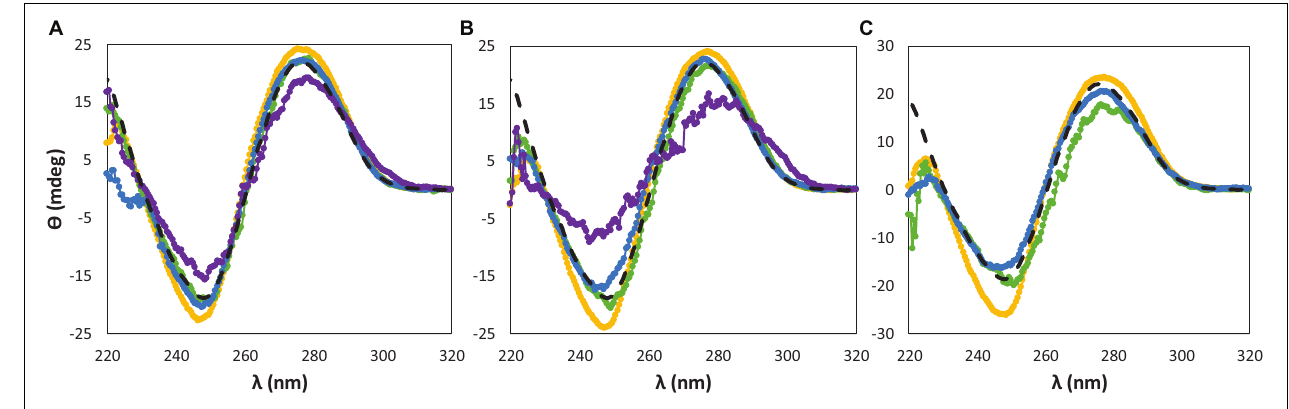
FIGURE 2 | CD spectra regarding the ellipticity, θ , of 0.01 g dm − 3 of β -DNA (from salmon testes) as a function of wavelength, λ , in 10 mM of Tris–HCl buffer (pH ≈ 7.2) aqueous solutions at different concentrations of bromide-based ILs: (A) 5 wt%; (B) 15 wt%; (C) 30 wt%. ( — ) only buffer; ( • ) [N 111 ( 2 OH ) ]Br; ( • ) [N 4444 ]Br;